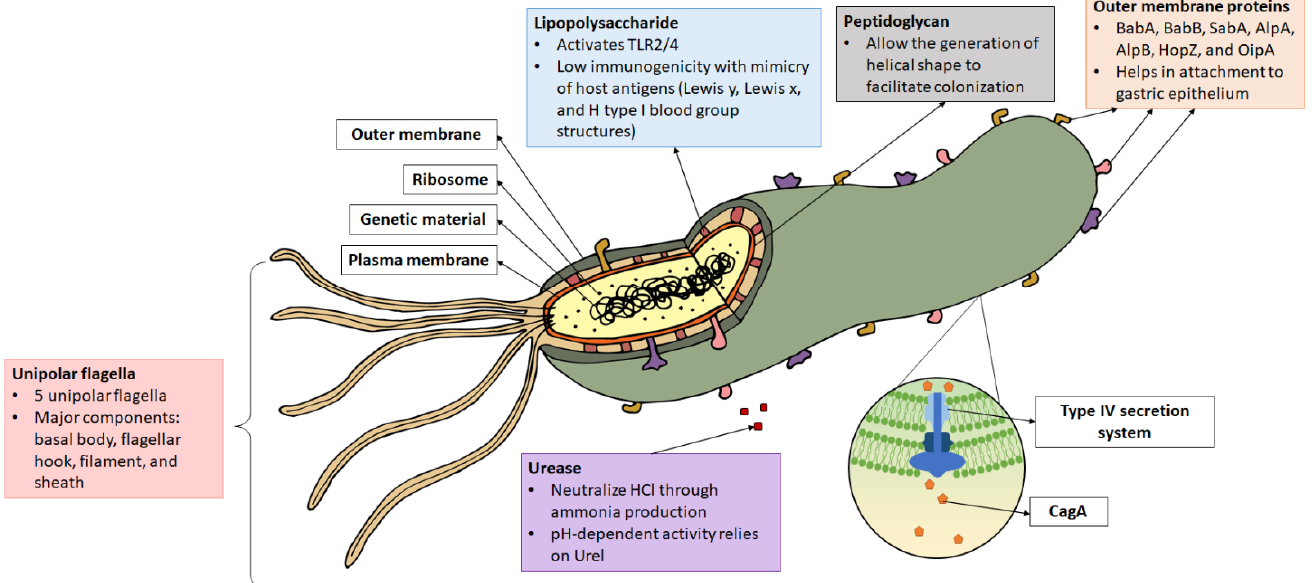
Figure 1. Structure of Helicobacter pylori . Virulence factors such as lipopolysaccharide (LPS), flagella, urease, peptidoglycan, outer membrane protein, CagA, and the type IV secretion system (T4SS) are as indicated. CagA is injected into the host cell via T4SS.